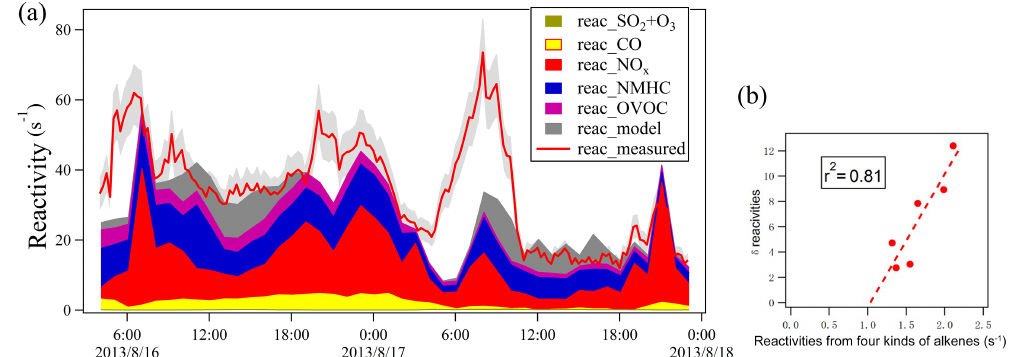
Figure 11. (a) Comparison between measured and calculated reactivity in Beijing from 16 to 18 August 2013. The shallow shaded region indicates uncertainty of measured reactivity. The same shallow shaded region in Fig. 12 represents the same. Panel (b) shows the correlation between missing reactivity measured in 2013 and reactivity assumed from branched–chained alkenes from 2005 in diurnal patterns. The four branched alkenes are isobutene, 2-methyl-1-butene, 3-methyl-1-butene and 2-methyl-2-butene.